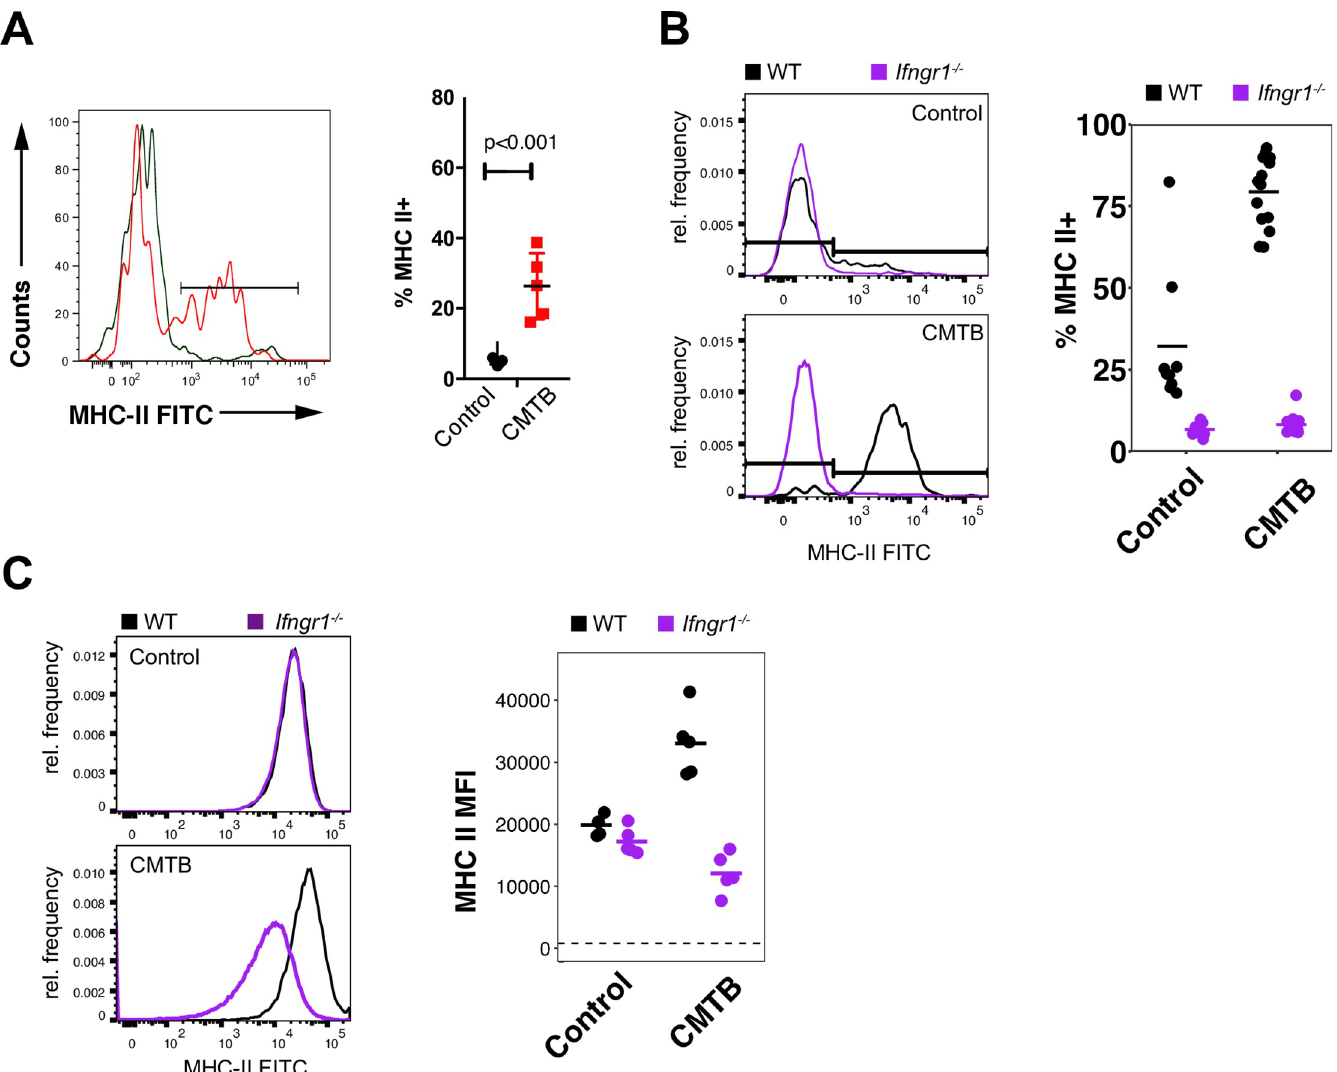
Fig 5. Immune activation in CMTB mice depends on systemic IFNg signaling. ( A ) MHC II expression on circulating monocytes in control and CMTB mice 6 weeks following the establishment of CMTB. (See S17 Fig for gating strategy.) Significance was measured by Student’s t -test. Error bars depict the mean and SD. ( B ) MHC II expression on circulating monocytes in WT: Ifngr1 -/- mixed bone marrow chimeras with and without CMTB. (See S20 Fig for gating strategy.) ( C ) MHC II expression on alveolar macrophages in WT: Ifngr1 -/- mixed bone marrow chimeras with and without CMTB. Dashed line indicates MFI of MHC II in unlabeled cells. (See S21 Fig for gating